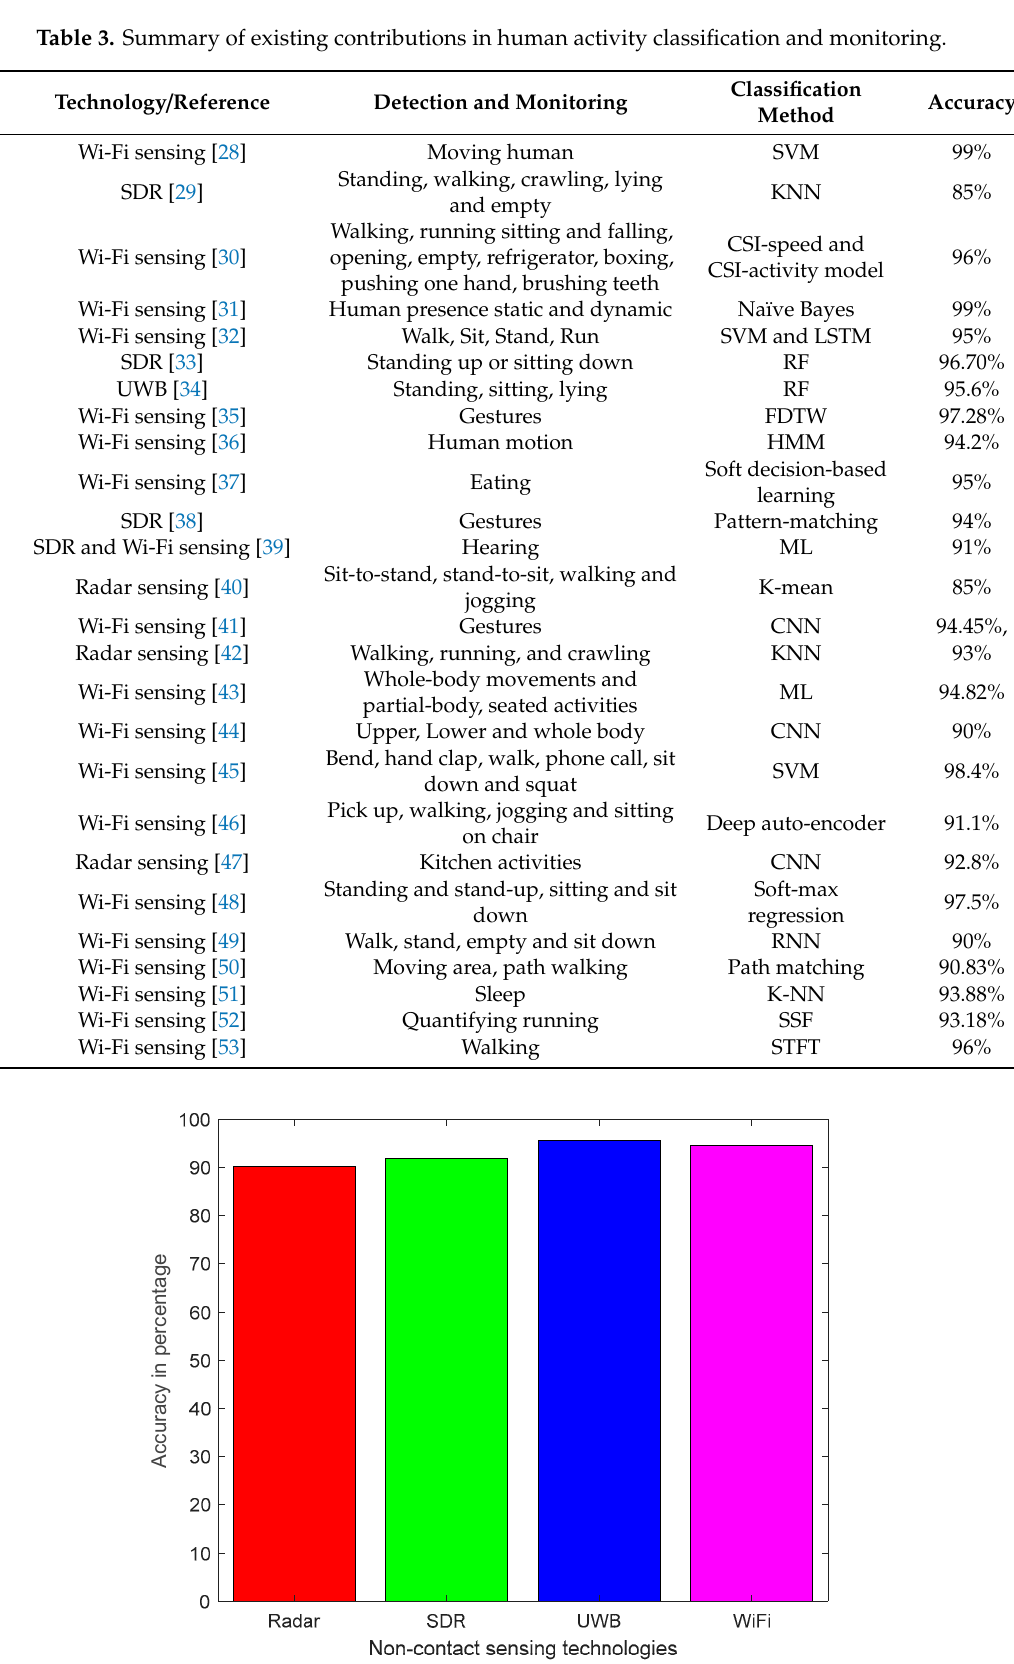
Figure 1. Average accuracy of non-contact sensing technologies for monitoring human activities. Table 3. Summary of existing contributions in human activity classification and monitoring.